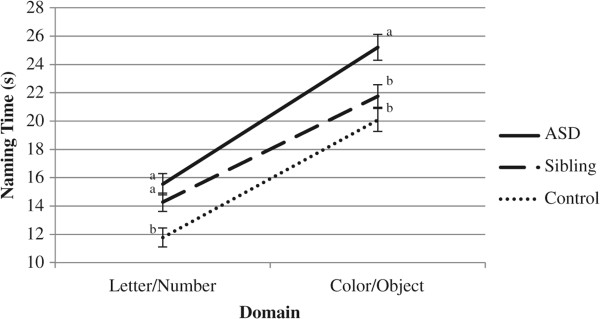
Line graph of domain by group interaction for naming time. Groups with different superscripts differ at p < .05.